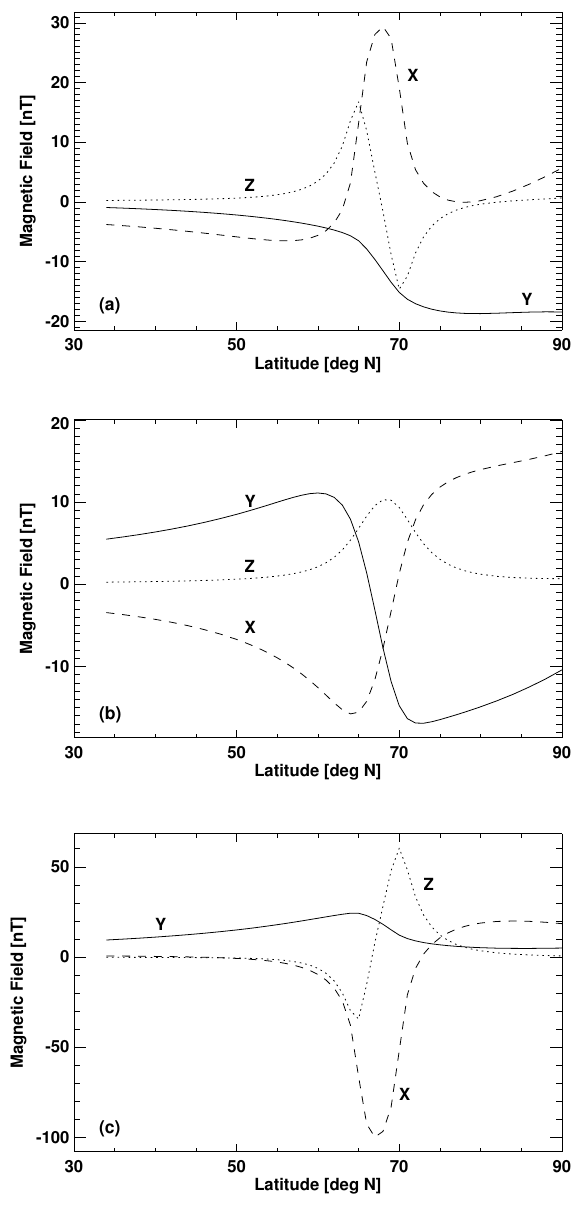
Fig. 5. Model latitude profiles for pre-substorm onset conditions in the evening (a) , midnight (b) and morning (c) sectors of the auroral